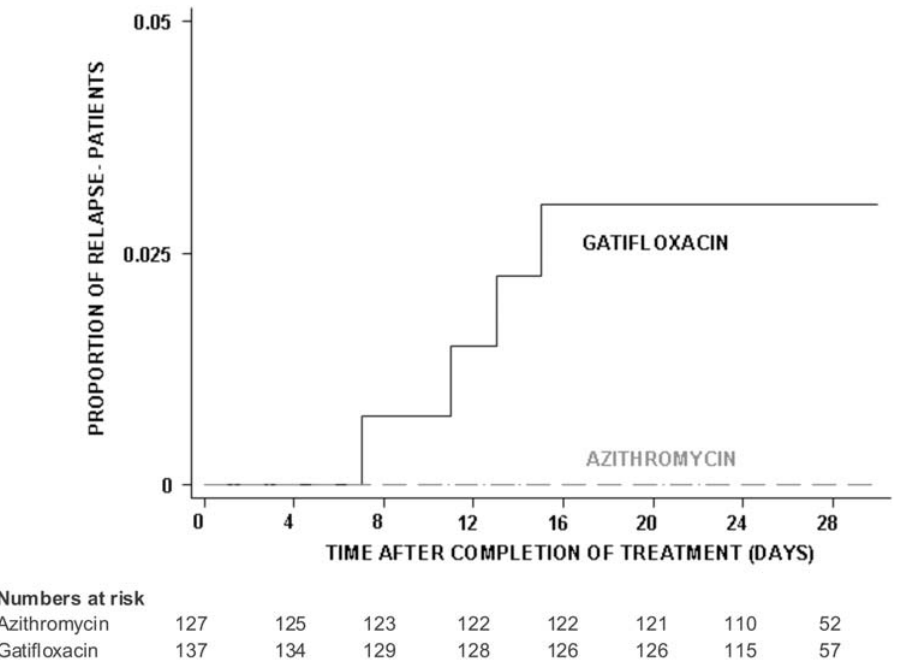
Figure 5. Proportion of patients with relapse in the culture confirmed population. Kaplan-Meier survival curve showing the proportion of patients with relapse in the culture confirmed population (PP analysis) by treatment